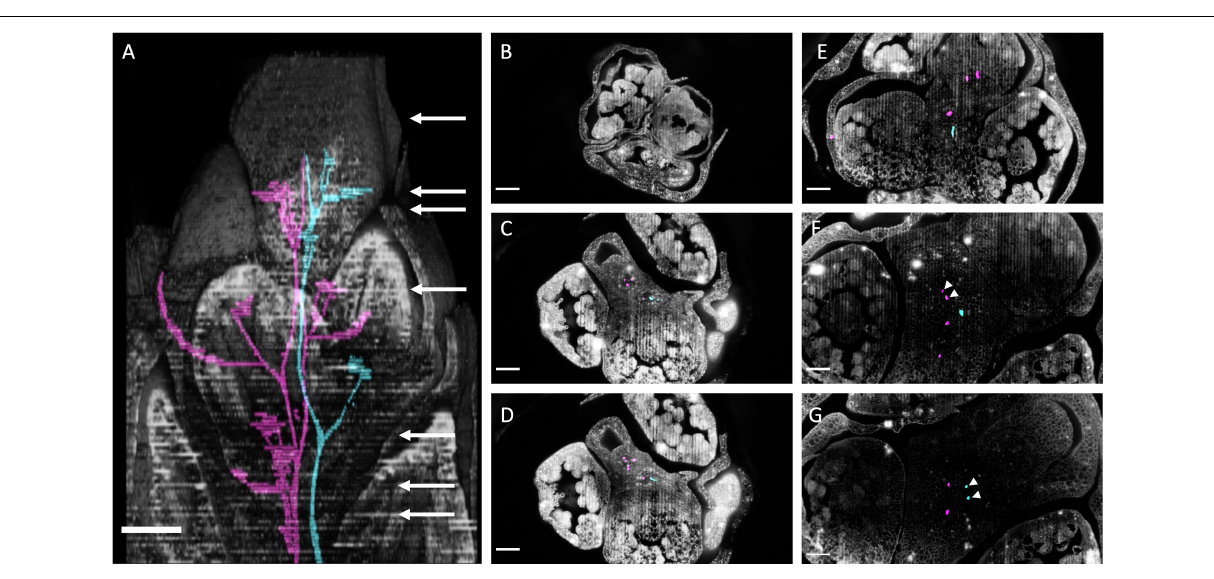
1600s (Basilius, 1613) and as such may have been influenced by artificial